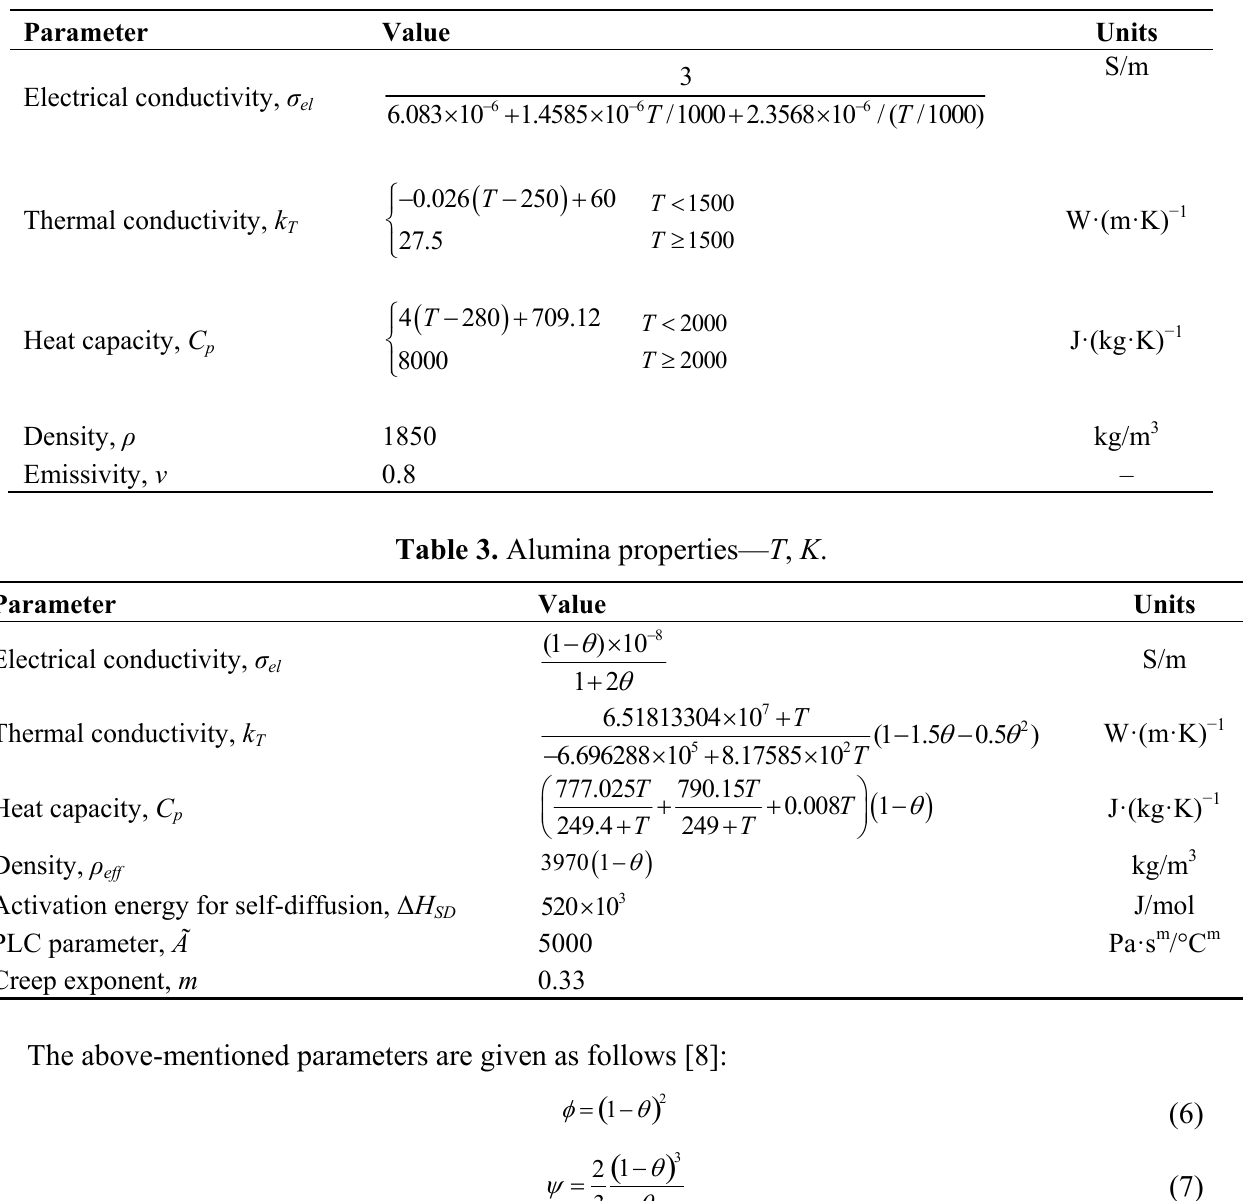
Table 2. Graphite properties— T , K .